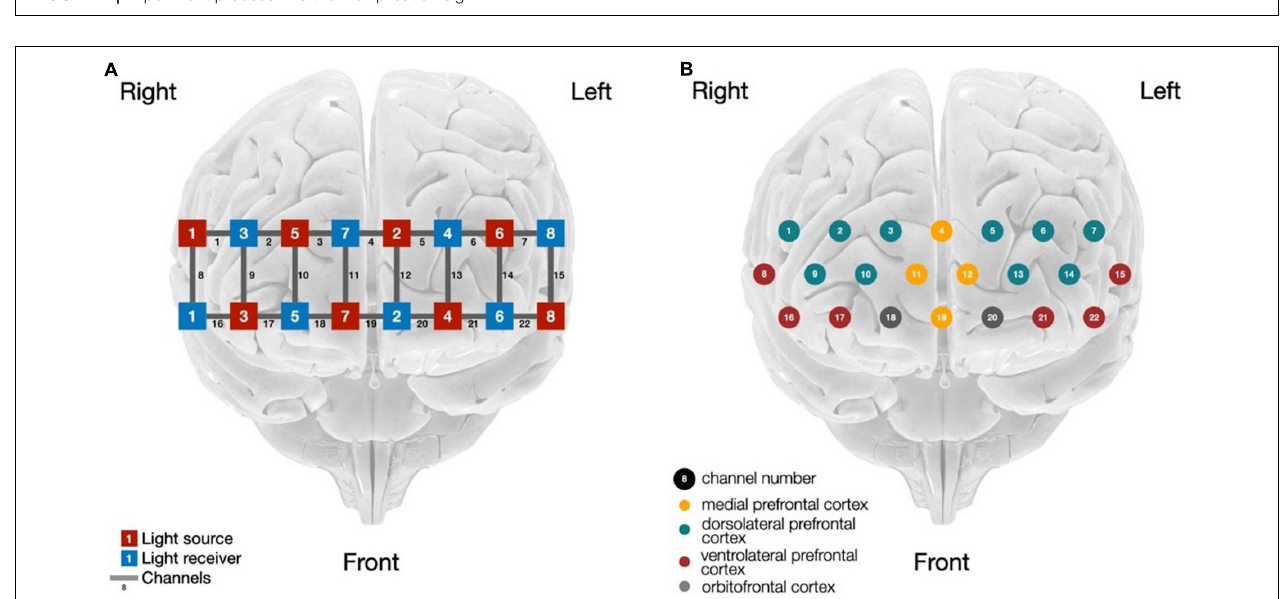
FIGURE 1 | Experiment process. * is the multiplication sign.